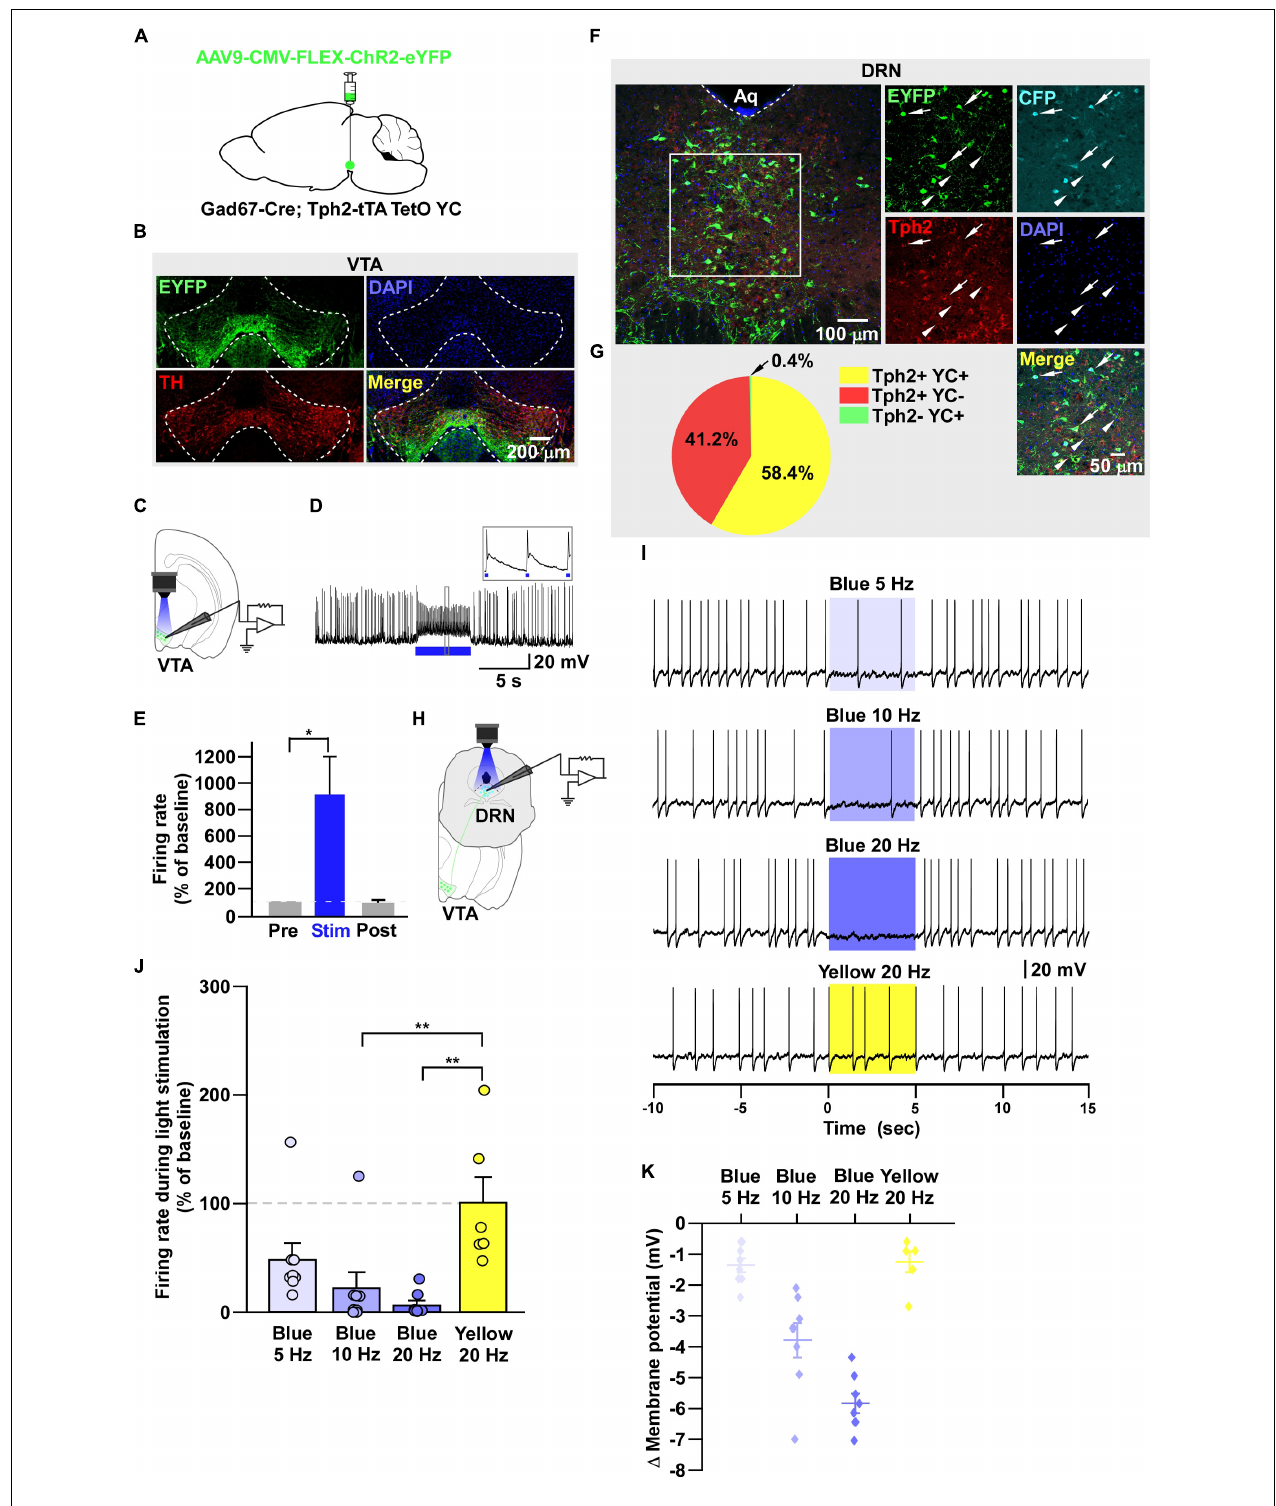
FIGURE 4 | DRN 5 - HT neurons are inhibited by VTA Gad67 + neurons. (A) Schematic of the AAV injection used to express ChR2-eYFP in VTA Gad67 + neurons. (B) Immunostaining shows the expression of ChR2-eYFP in the VTA, indicating there is no overlap with TH-positive cells. Green (EYFP), red (TH), blue (DAPI), yellow (merge). (C) Schematic of the setup and (D) a representative trace from the in vitro whole-cell current clamp recordings from ChR2-expressing VTA Gad67 + neurons. Blue bar indicates 10 Hz of blue light (3.19 mW) stimulation for 5 s. Inset shows the pulse generated-action potentials. (E) Summary of (D) ( n = 8 cells from 4